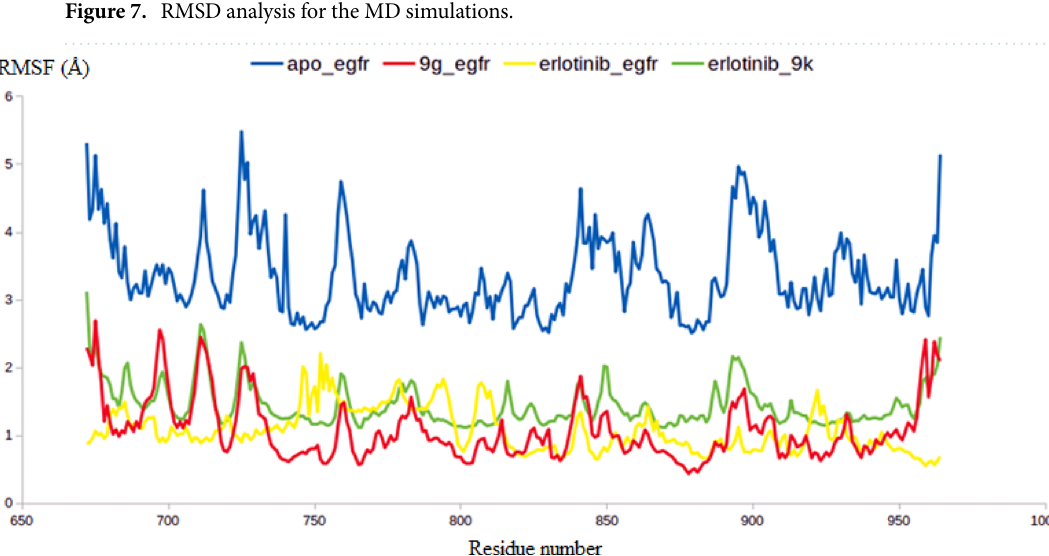
Figure 8. The RMSF analysis for the MD